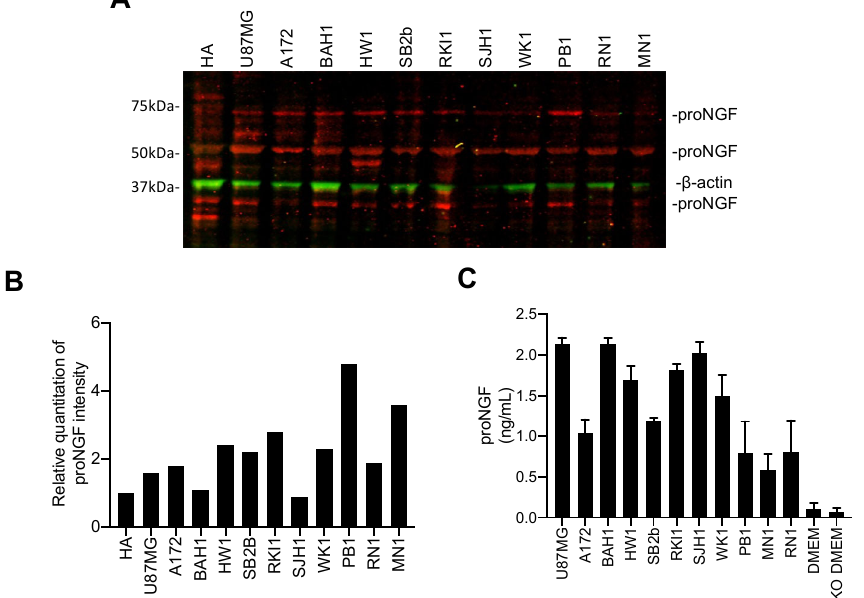
Figure 3. ProNGF protein expression in a panel of GBM cell lines. ( A ) Western blotting for proNGF was performed with cellular proteins extracted from HA (non-tumorigenic human astrocytes) cells and the following human GBM cell lines: U87MG, A172, BAH1, HW1, SB2b, RKI1, SJH1, WK1, PB1, RN1 and MN1. ProNGF was detected as 35, 55 and 75 kDa bands in all cell lines. ( B ) Densitometric analysis of the combined signal intensity obtained from the 3 proNGF bands. ( C ) ProNGF secretion was quantified by ELISA in conditioned medium of GBM cell lines. ProNGF concentrations are represented in ng/mL. Data shown are the mean ± SD of three independent experiments. DMEM: medium for U87MG and A172; KO DMEM: medium for all of the patient-derived GBM cells. To investigate the functional features of proNGF in vitro, we first inhibited proNGF with anti-proNGF blocking antibodies in the same panel of GBM cell lines and the effect on both cell invasion and cell growth was analyzed. The anti-proNGF blocking antibody ever it did not affect cell growth in GBM cells with unmethylated MGMT gene promoter (Supplementary Figure S2A,B). Since MGMT promoter methylation has been reported to predict the outcome in GBM patients to alkylating chemotherapeutic agents [3], we then tested the effect of anti ‐ proNGF in combination with TMZ on GBM cell viability. A further inhibition of cell viability by anti ‐ proNGF was found in three (U87MG, RKI1 and SB2b) out of six GBM cell lines with methylated MGMT gene promoter when co ‐ treated with TMZ compared to TMZ alone (Figure 4A). In contrast, anti ‐ proNGF could not further sen ‐ sitize cells to TMZ in GBM cell lines with unmethylated MGMT gene promoter (Figure 4B).